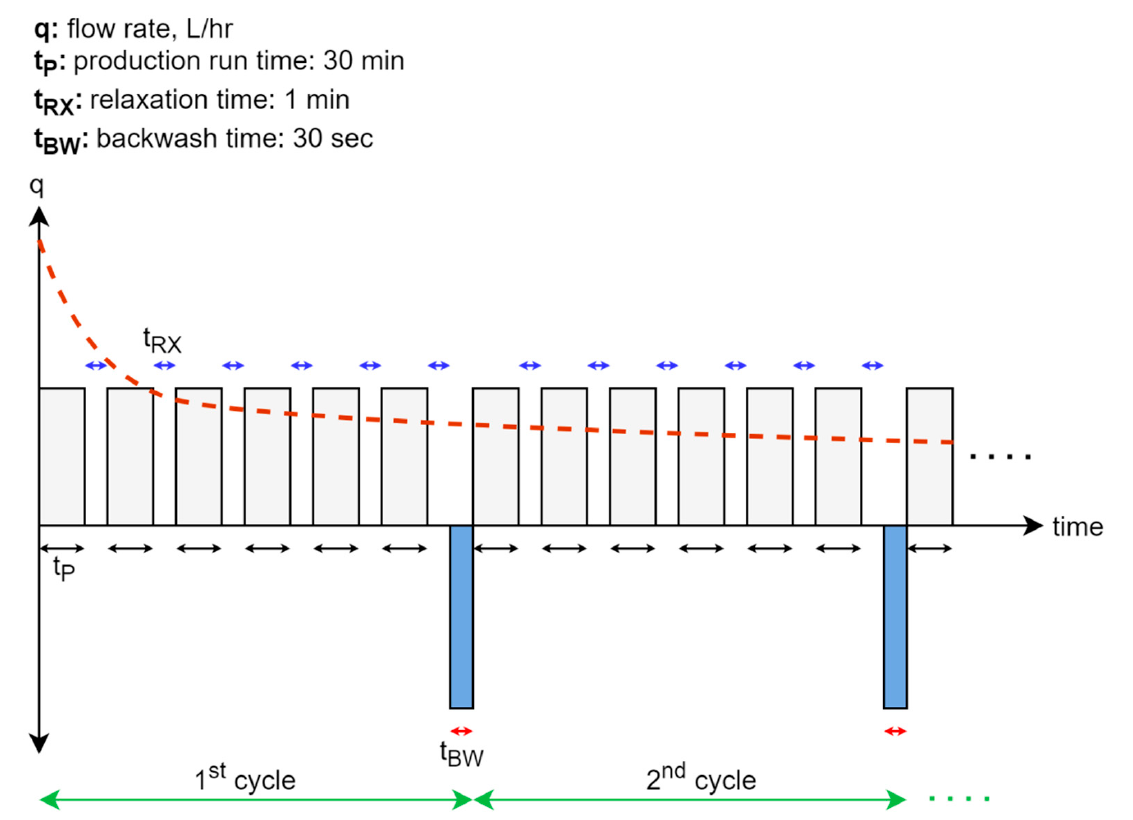
Figure 2. Conceptual cyclic membrane operation compared to continuous operation without relaxation and backwashing cycles (red line). In the continuous operation, a higher initial flux is achieved. However, rapid cake formation on the membrane causes the flux to decline.